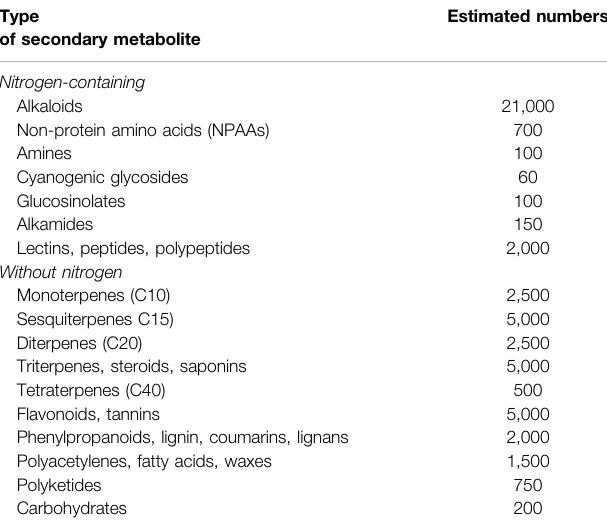
TABLE 1 | Estimated number of plant secondary metabolites (Wink,